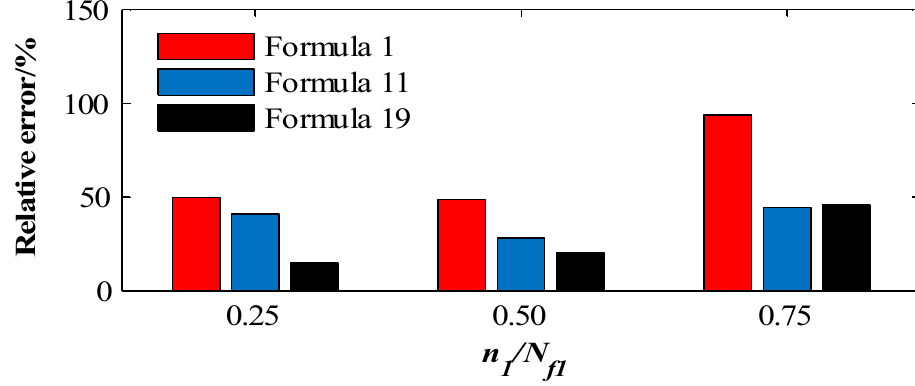
Figure 12. (284.4–331.5 MPa) The relative error of each model under different n 1 /N f 1 (45# steel). It can be seen from Figures 11 and 12, for 45# steel, under high–low load loading, as the proportion of high load continues to increases, the relative error of Miner’s rule in- creases significantly. The relative error fluctuation of the toughness dissipation model is relatively stable, and the overall value is smaller than Miner’s rule. The relative error be- tween the result obtained by the improved model and the actual value is the smallest among these three models. In the case of low–high loading, the error between the results obtained by the three models and the actual value is smaller than the error obtained in the case of high–low loading. Like the results of 18CrNiMo7-6, both reflect that under high–